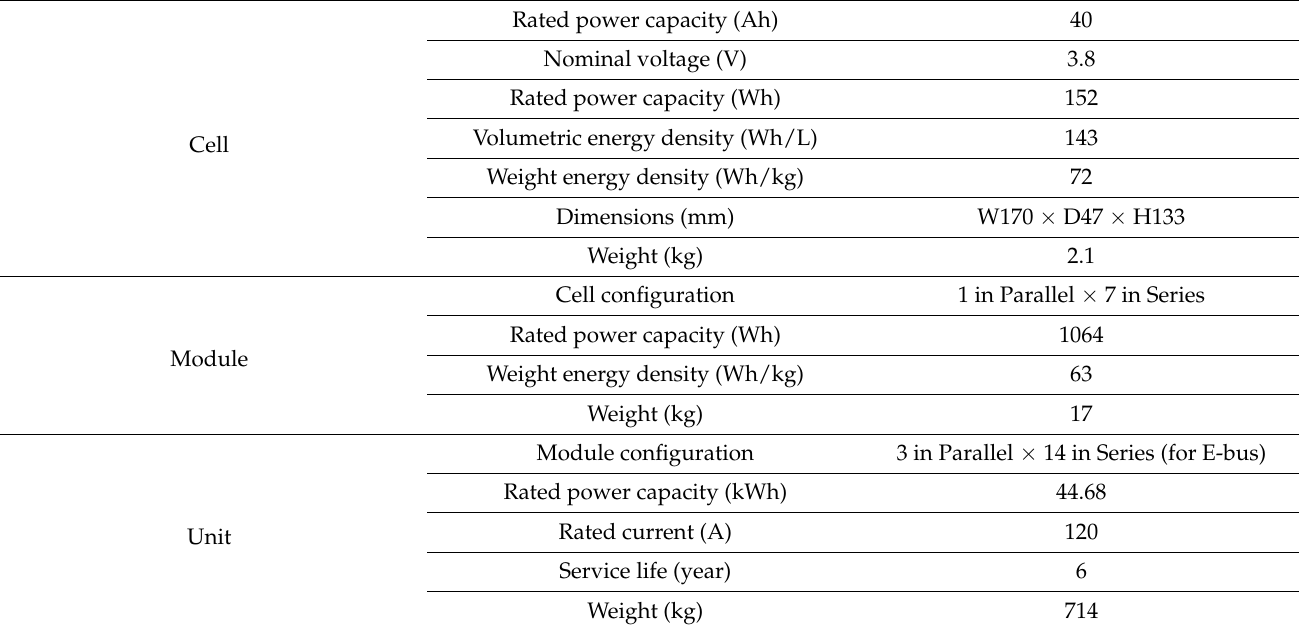
Table 1. System specification.